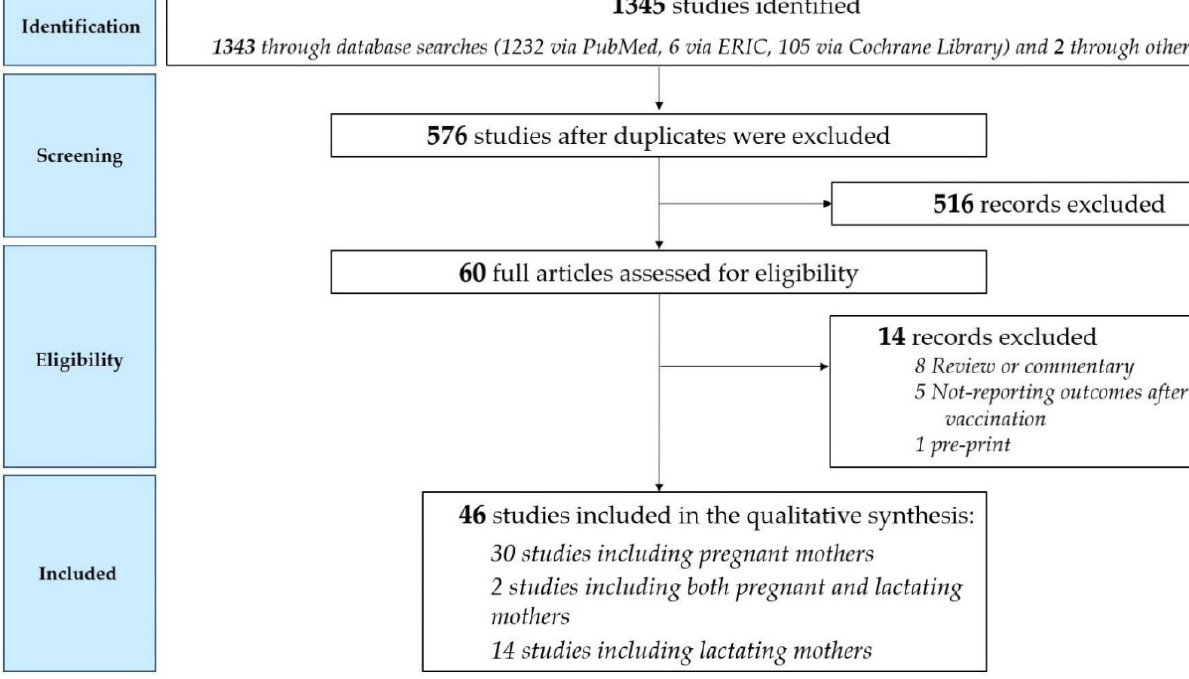
Figure 2. Study selection process.